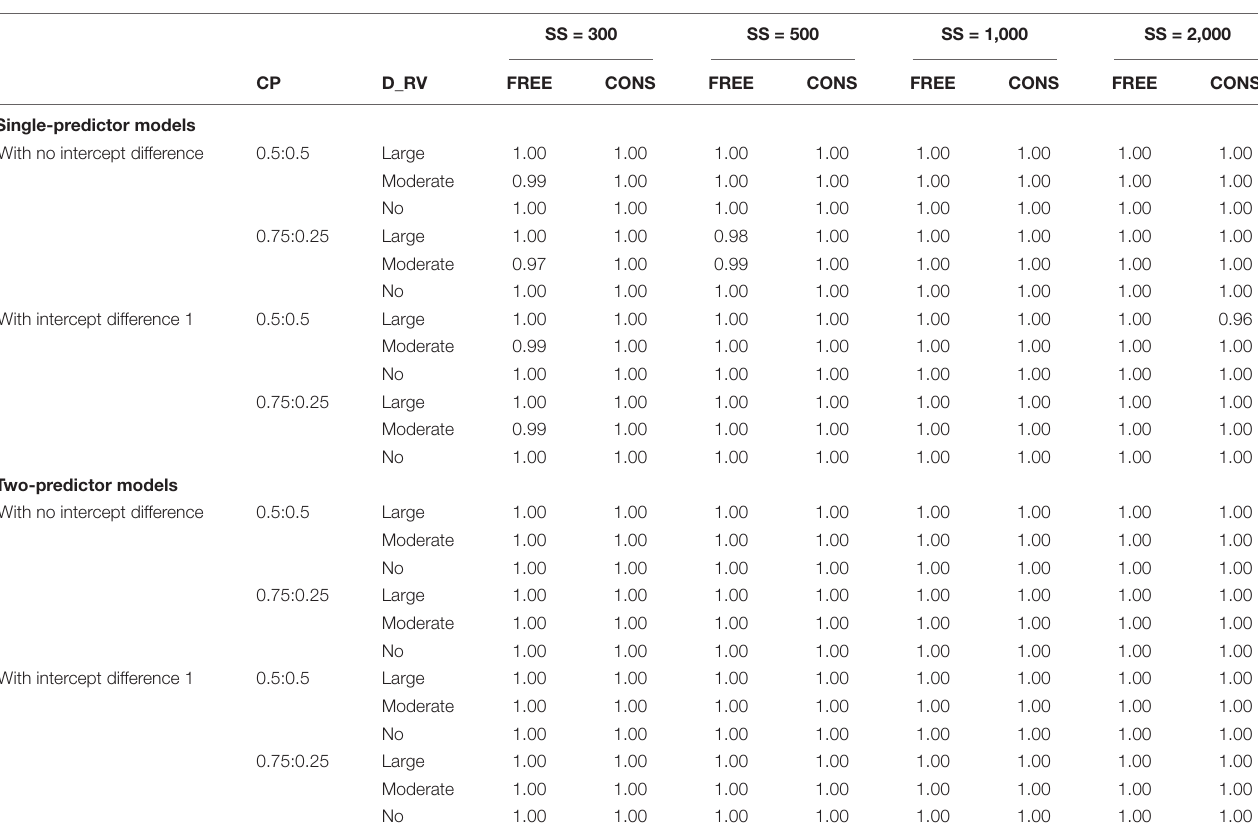
TABLE 2 | Convergence